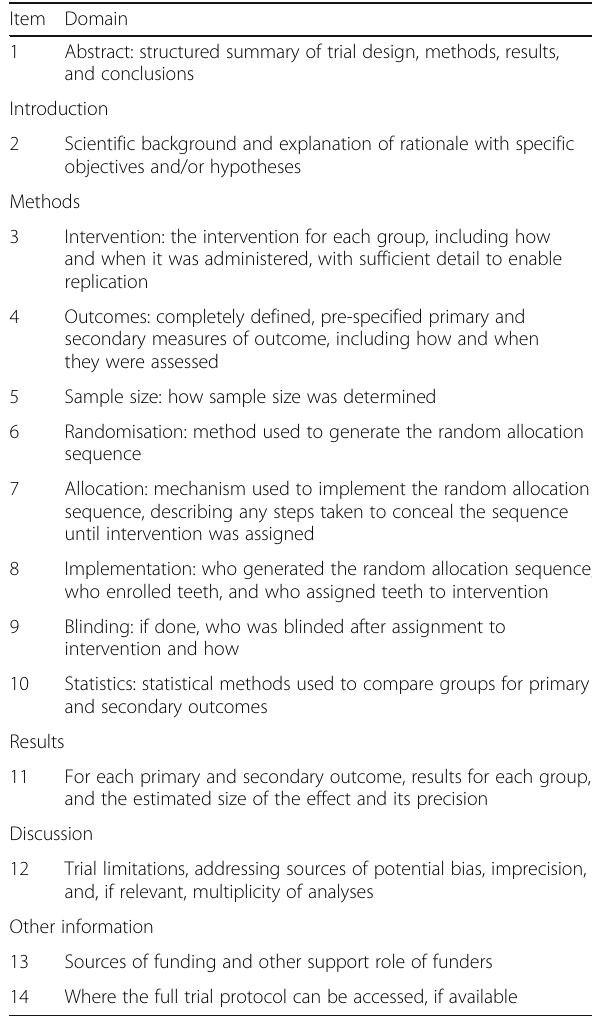
Table 2 Modified CONSORT checklist of items for reporting in vitro studies of dental materials [16] Item